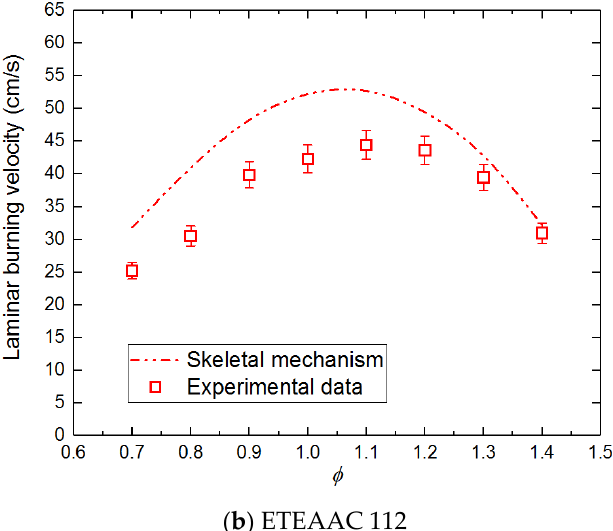
Figure 7. Comparison of the laminar burning velocity of simulation and experimental results.